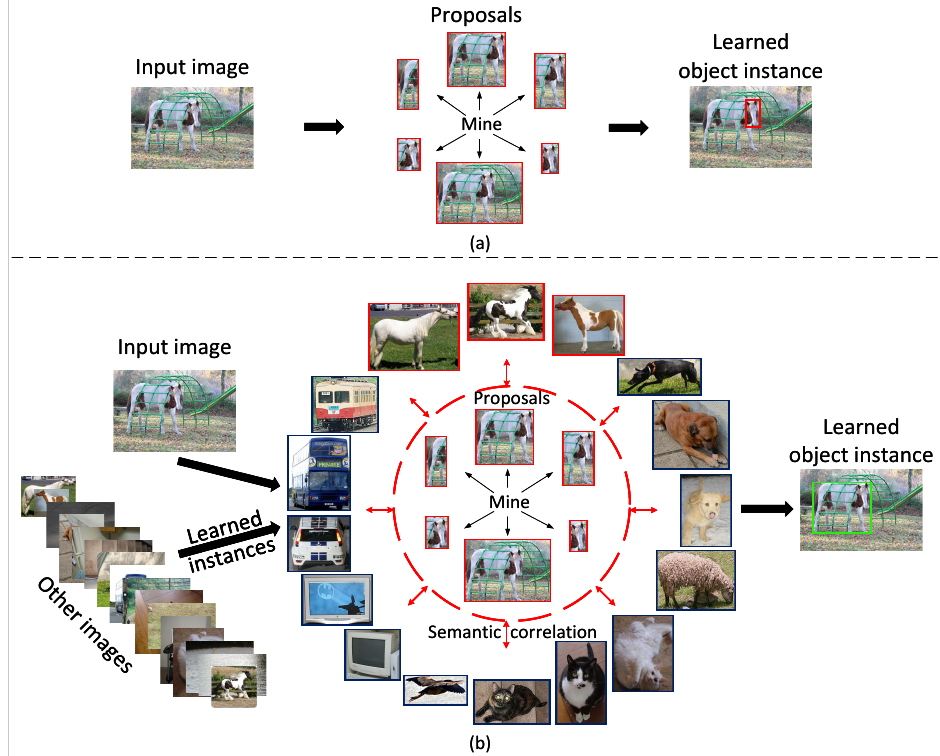
Figure 1. Illustration of our motivation through data flow. ( a ) Most WSOD methods usually learn object instances from region proposals of current input image. ( b ) Our method establishes instance correlations with other images to guide instance representation learning for the current input